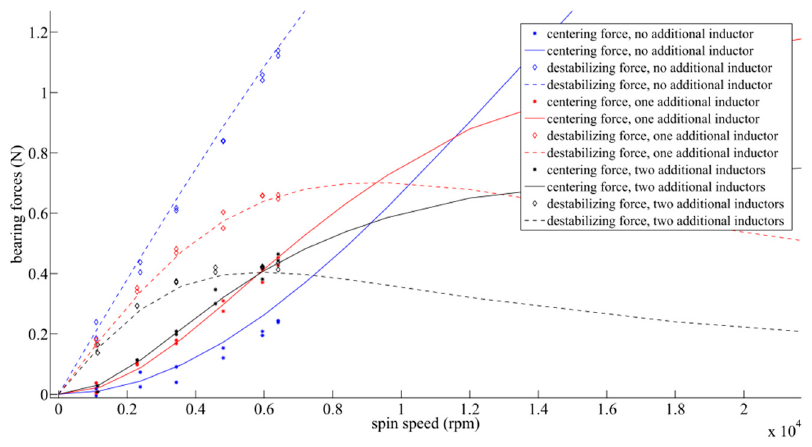
Figure 21. Bearing forces when adding additional inductors in series with each coil as a function of the spin speed for a center shift of 0.75 mm.